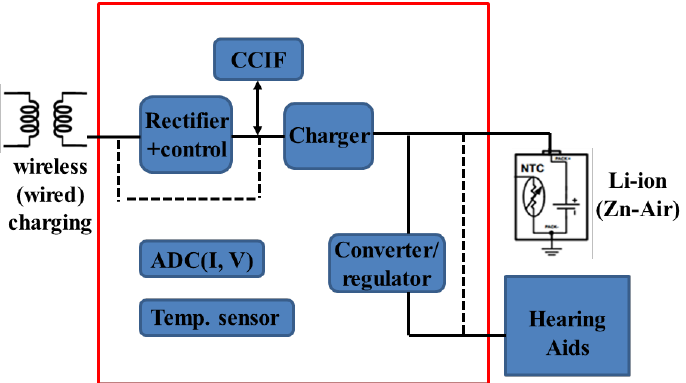
Figure 6. Block diagram of the battery/power management unit.